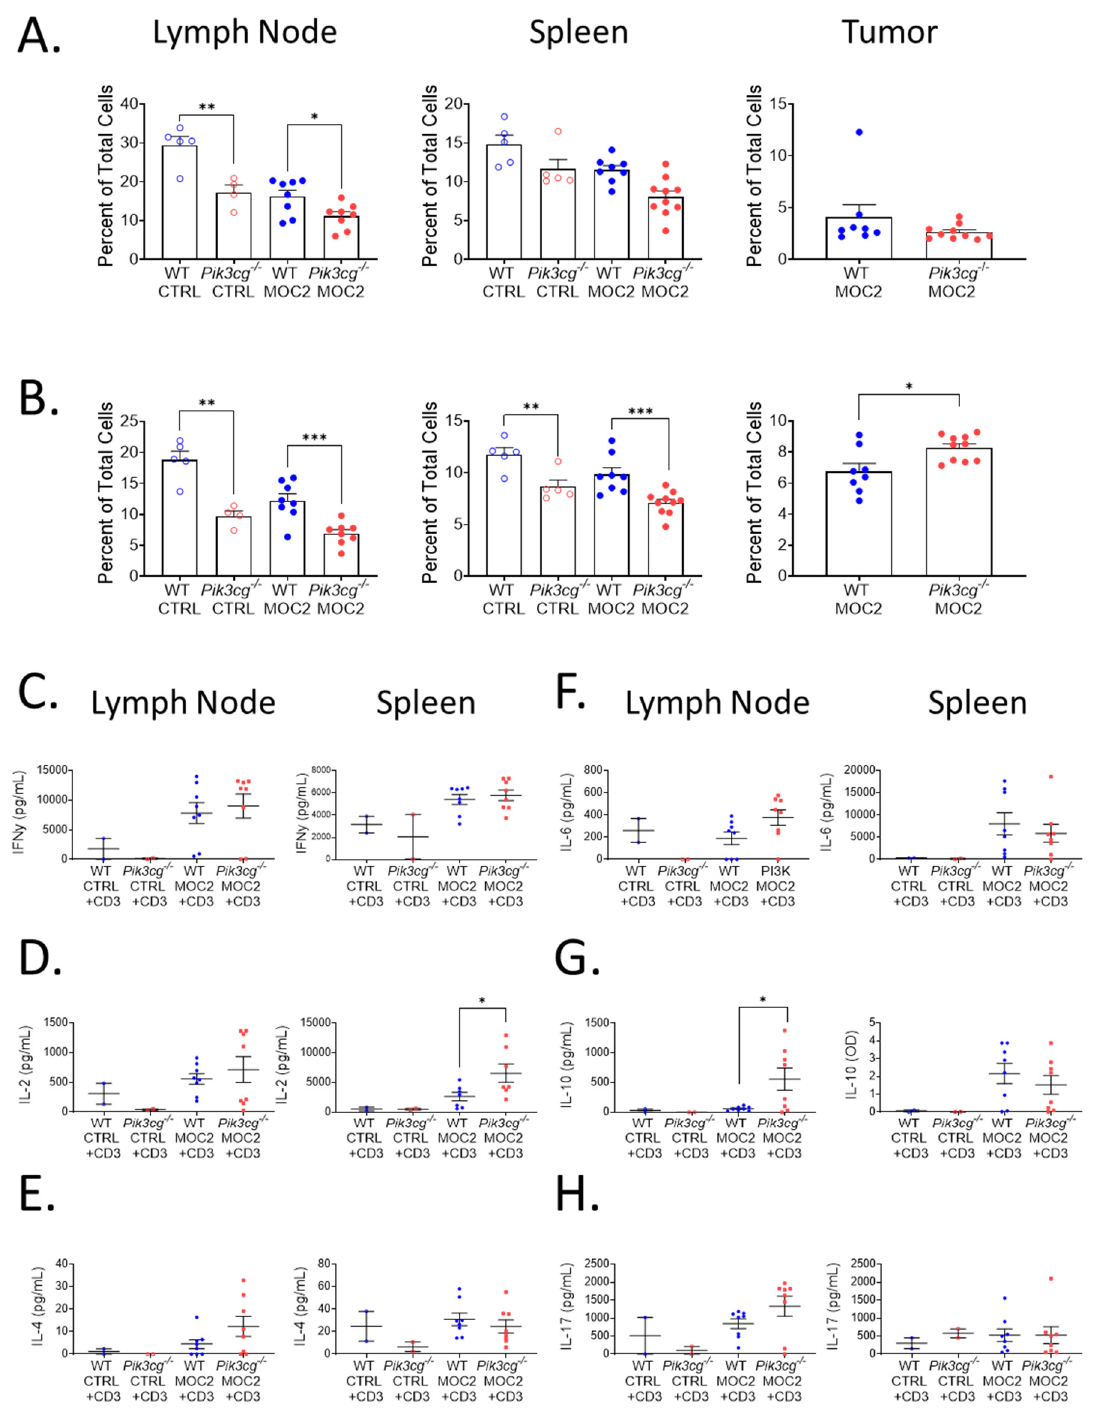
Figure 2. Tumor-bearing Pik3cg − / − mice do not possess inherent deficiencies in T-cell activity. ( A , B ) Population frequency of ( A ) CD4 + T-cells and ( B ) CD8 + T-cells among total live cells within the lymph node, spleen, and tumor of WT and Pik3cg − / − mice as determined by flow cytometry. ( C – H ) Production of ( C ) IFN- γ , ( D ) IL-2, ( E ) IL-4, ( F ) IL-6, ( G ) IL-10, ( H ) IL-17 by CD3-stimulated T-cells isolated from the lymph node and spleens of experimental mice as determined by cytokine ELISA. * p -value < 0.05; ** p -value < 0.01; *** p -value < 0.005 between groups, as determined by Student’s t